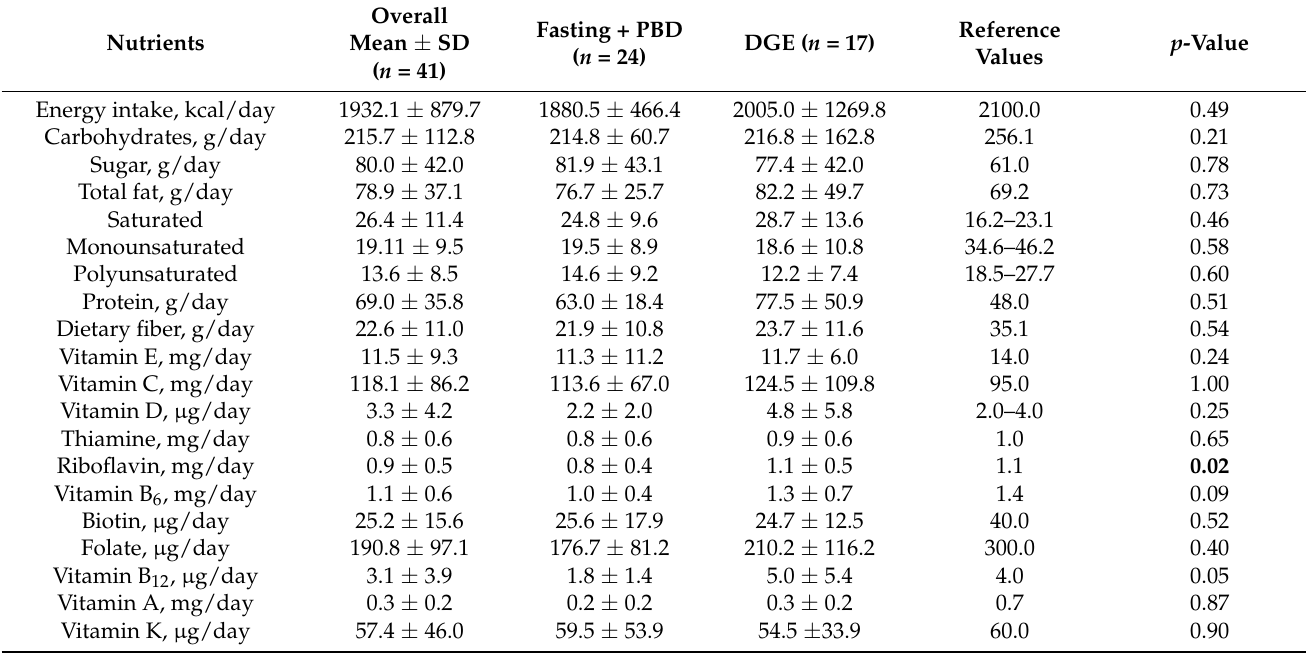
Figure 1. CONSORT flow diagram. Table 1. Nutrient supply of participants with RA at study week -1 as well as the DGE reference values for adult women [22] .